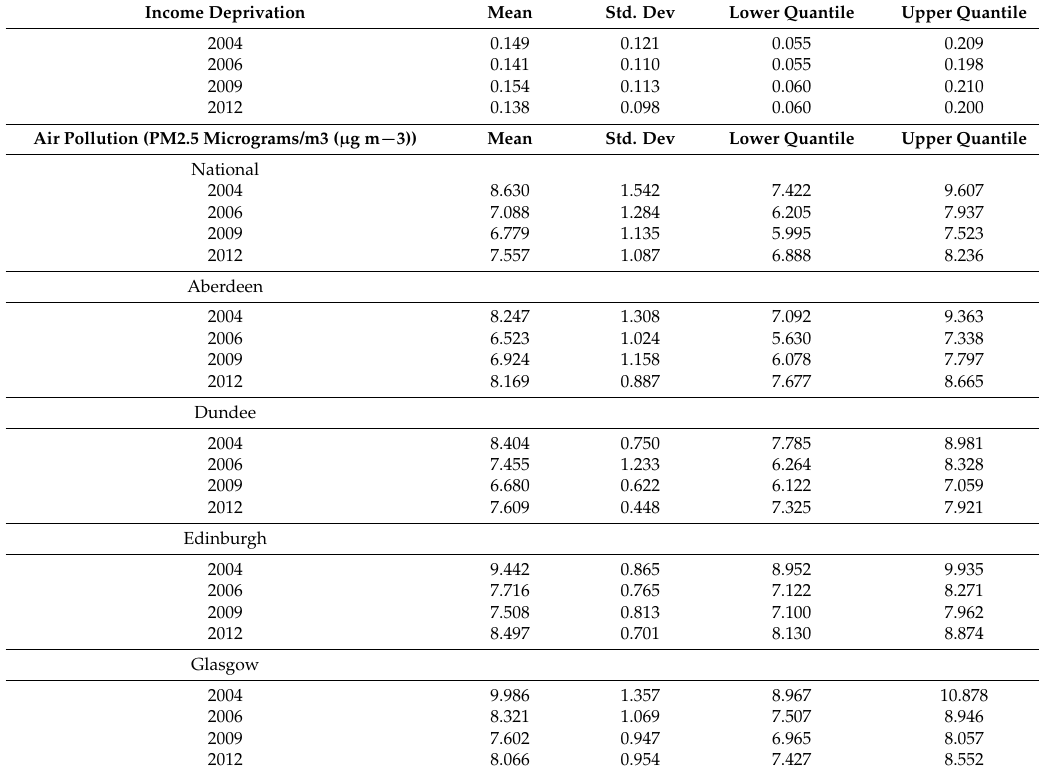
Table 1. Summary statistics for Income Deprivation and air pollution (PM 2.5 ). Income